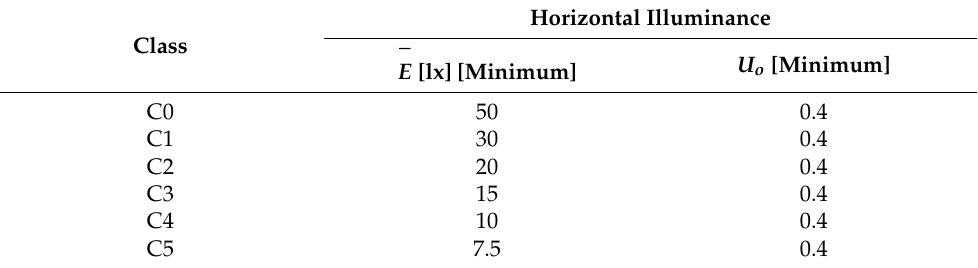
Table 1. The required illuminance levels for class C [39].